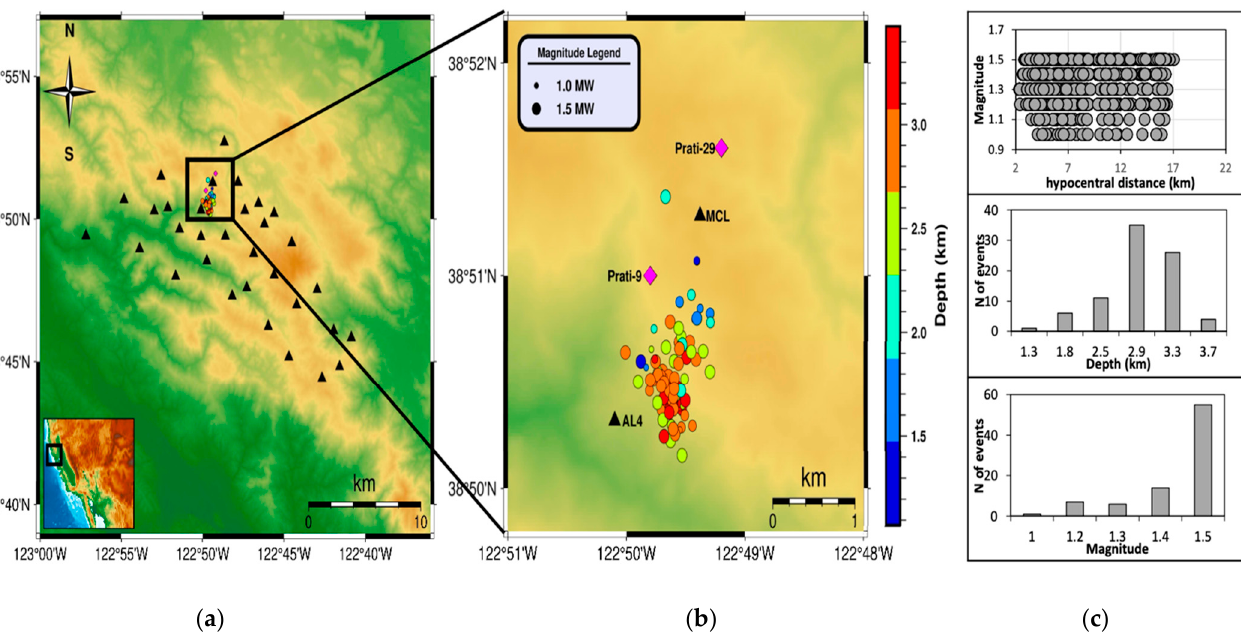
Figure 1. ( a ) Map view of the TG area. The black triangles mark the location of the network stations. The black square highlights the area of the selected events. In the bottom left panel, the black square identifies the overall TG area in California; ( b ) Zoomed-in view of panel ( a ) for the selected events. Every event is marked with a circle whose size scales with magnitude, while the colors follow depth information according to the color bar on the right. The pink diamonds specify the locations of Prati- 9 and Prati-29 wells. The two closest stations are marked with black triangles; ( c ) Top: number of records as a function of hypocentral distance; middle: depth distribution; bottom: magnitude distri- bution.